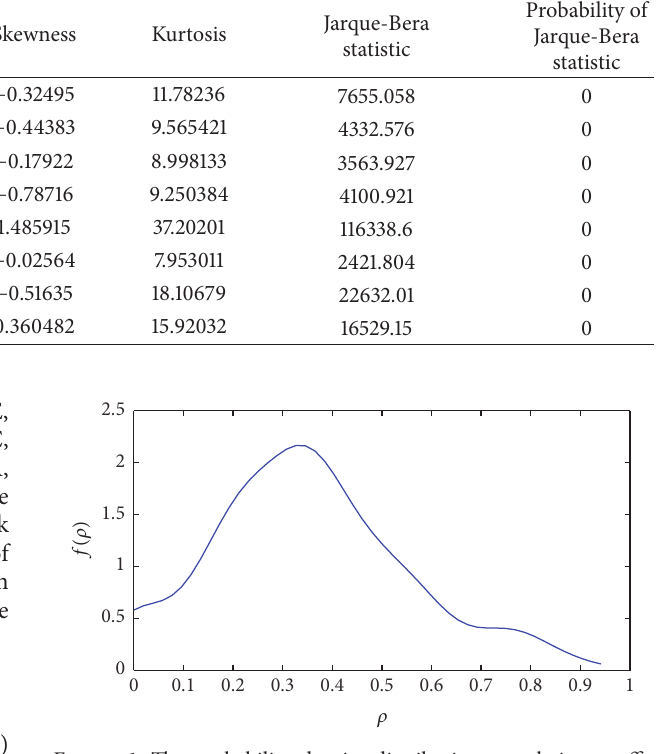
Figure 1: The probability density distribution correlation coeffi- cients in ISMN. Most of the coefficients are between 0.1 and